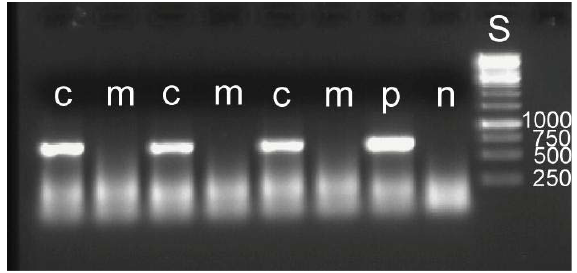
Figure 6. Molecular detection of symbiotic bacteria in larvae of Donacia sp. using specific PCR primers. In the manipulated samples, the bacterial mass adhering to the egg had been removed before hatching. c: control samples from normally hatched larvae; p: positive control, sample known to contain symbiont DNA; m: manipulated sample; n: negative control, distilled water as sample; S: size standard with the fragment sizes